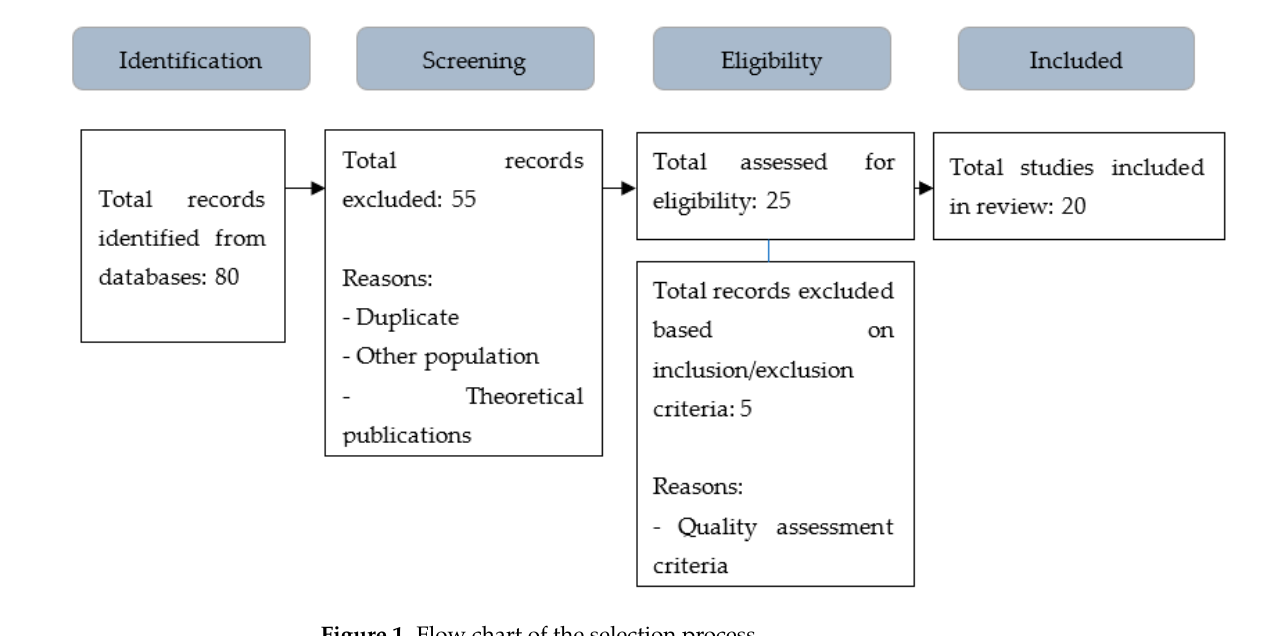
Figure 1. Flow chart of the selection process.